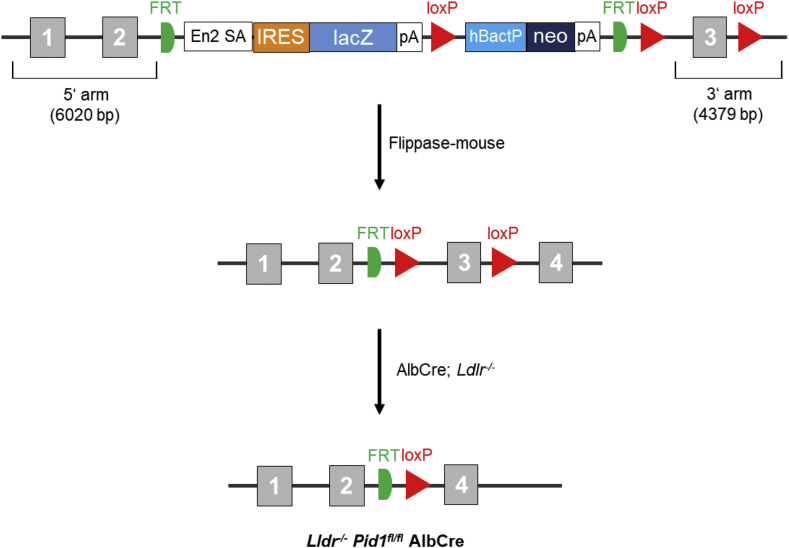
Generation of Pid1 knockout mice. The “Knockout-First-Reporter Tagged Insertion“ Pid1tm1a(KOMP)Wtsi allele present in the ESC clone EPD0579_4_G03 and obtained from the NCRR-NIH supported KOMP Repository (www.komp.org) was generated through insertion of the L1L2_Bact_P cassette into intron 2 of the Pid1 gene at position -84038956 of mouse chromosome 1. Liver-specific Pid1 knockout mice were generated by crossing “knockout-first” mice with mice expressing flippase [45], yielding mice with floxed 3rd exon of Pid1. Crossing these mice with mice expressing liver-specific Cre-recombinase (albumin-promotor driven Cre expression) was used to produce liver-specific Pid1 knockout mice. By crossing these mice with LDLR deficient mice, double knockout mice (Ldlr−/−Pid1fl/fl AlbCre+) and respective controls (Ldlr−/−Pid1fl/fl AlbCre-) were generated.